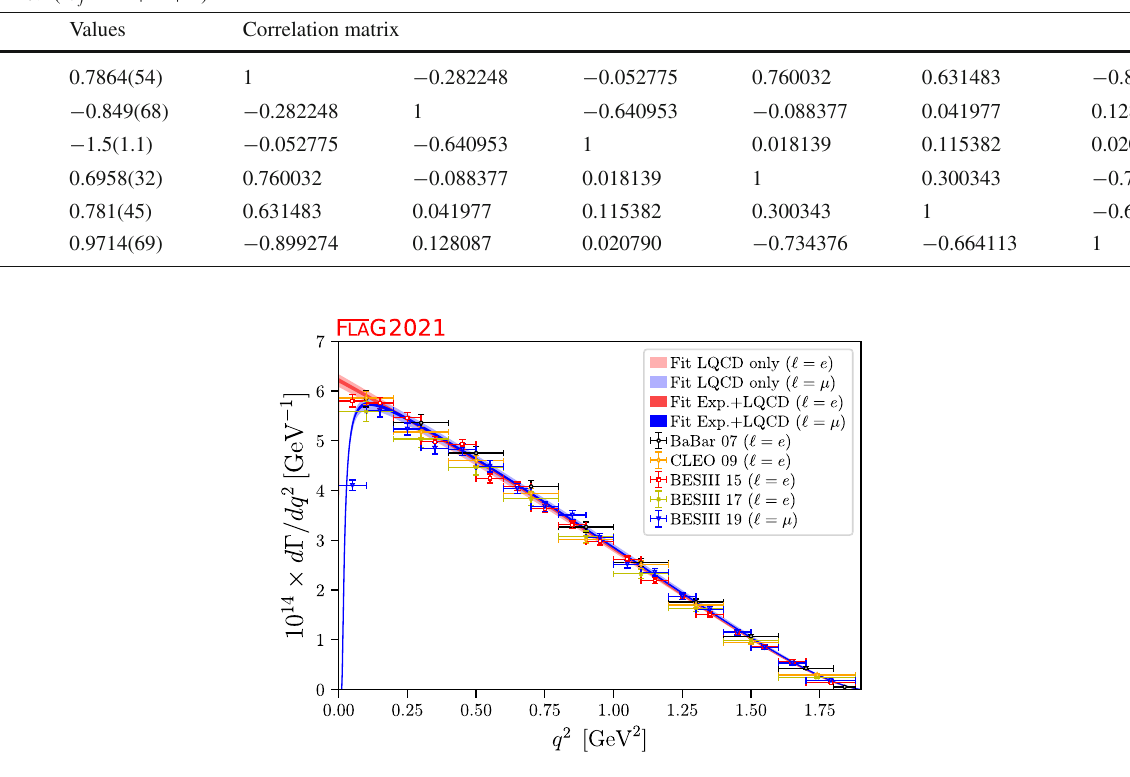
Table 39 Coefficients for the N + = N 0 = 3 z -expansion of the D → K form factors f + and f 0 , | V cs | , and their correlation matrix D → K (cid:6)ν ( N f = 2 + 1 + 1 )